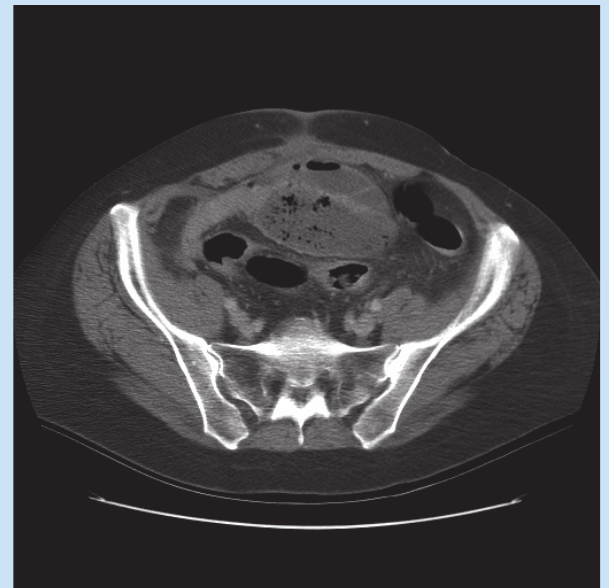
Fig. 1. Axial CT in a 22-year-old female patient with history of Crohn dis- ease demonstrating the small bowel faeces sign in a distended ileal loop. Adjacent transition zone with collapsed distal small bowel is